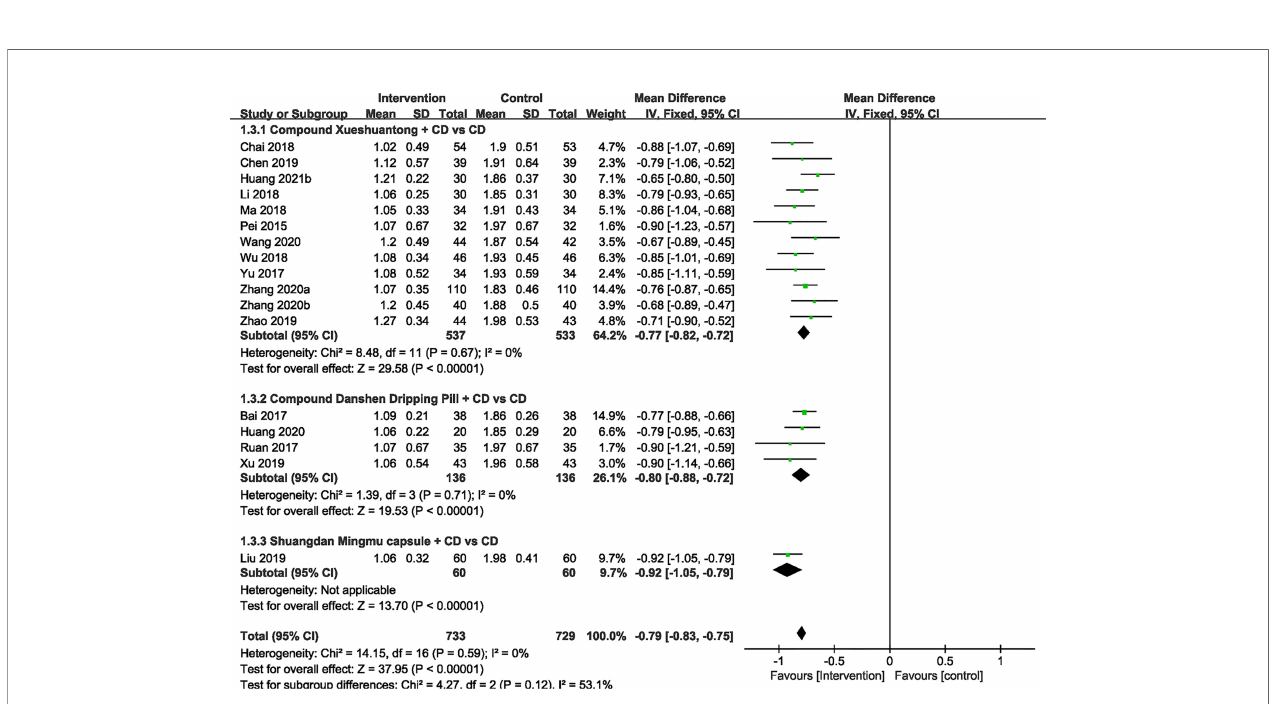
FIGURE 4 | Forest plots of comparison of ocular fundus signs for CPMs plus CD versus CD alone. Hemorrhage area.